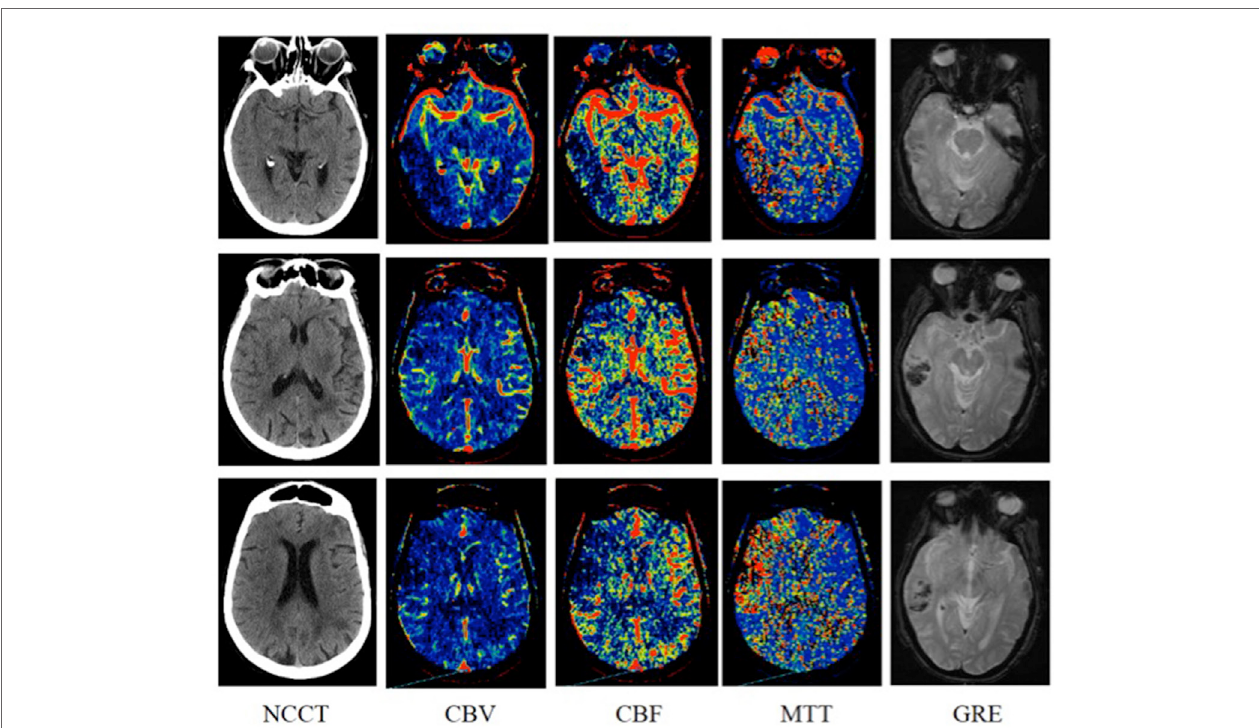
FigUre 1 | An 87-years-old woman was imaged 3 h after symptom onset with left-sided weakness. Subtle loss of gray-white matter differentiation in the right insular ribbon on non-contrast computed tomography [NCCT; Alberta Stroke Program Early Computed Tomography (CT) score (ASPECTS), 9]. Reduced cerebral blood volume (CBV; ASPECTS, 5) involving the right temporal lobe and frontal lobe in the middle cerebral artery (MCA) territory and more obvious abnormality on cerebral blood flow (CBF; ASPECTS, 4) and mean transit time (MTT; ASPECTS, 4) in the right temporal lobe, frontal lobe and insular cortex. After 7 h of symptom onset hyperintensity on diffusion-weighted imaging (DWI) in the right temporal lobe, frontal lobe, and insular cortex and hypointensity on T2*-weighted gradient echo (GRE) was identified in the right temporal